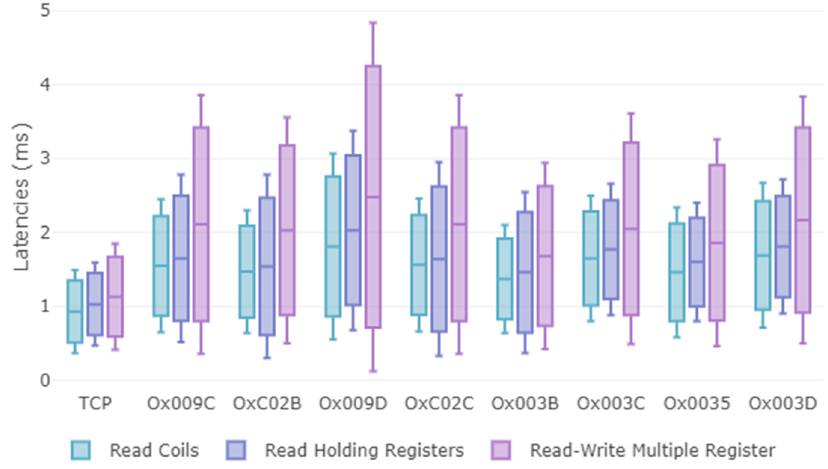
Figure 12. Boxplot (maximum, average, minimum) of latencies (ms) for each of the cipher suites (without applying RBAC model).